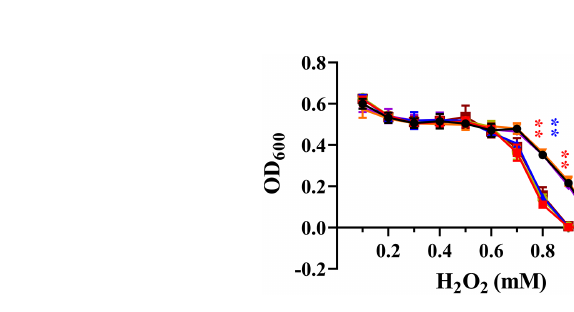
the fl agellar transcriptional regulator encoding genes fl hC and fl hD , an RNA polymerase sigma factor encoding gene fl iA , fl agellar motor switch protein encoding genes fl iG , fl iM and fl iN , and a fl agellar motor stator protein encoding gene motA by RT-qPCR. Results showed that their expression were decreased markedly in D arcA and D arcA(pBBR1) mutants compared with the wild-type strain EC1 and the complemented strain D arcA (arcA) (Figure 3C), validating the key role of ArcBA in positive regulation of bacterial motility.